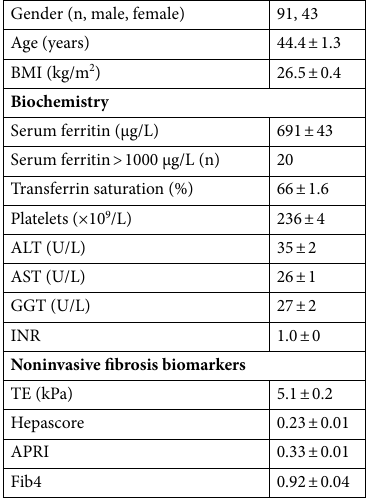
Table 1. Baseline demographic and biochemical characteristics of study patients. All data are presented as the mean ± SE. ALT: alanine aminotransferase; APRI: aspartate aminotransferase to platelet ratio index; AST: aspartate aminotransferase; BMI: body mass index; Fib4: fibrosis-4; GGT: gamma-glutamyl transferase; INR: international normalised ratio; TE: transient